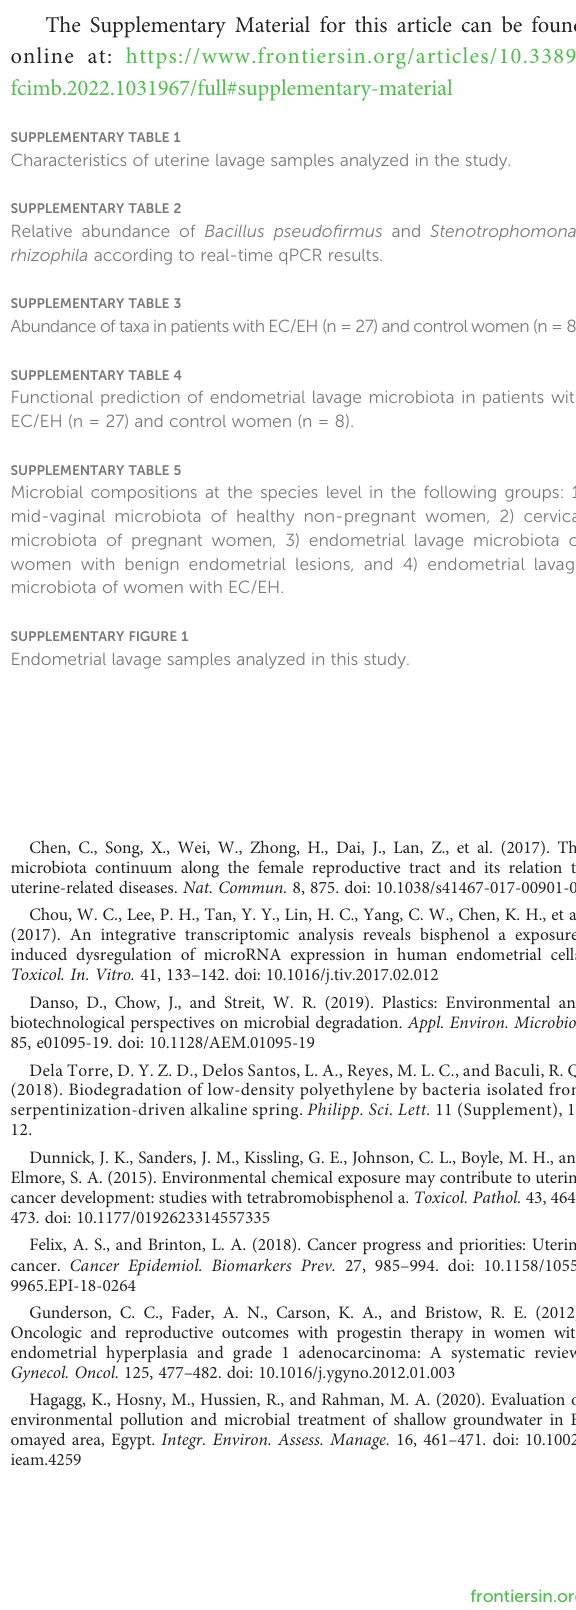
Characteristics of uterine lavage samples analyzed in the study.